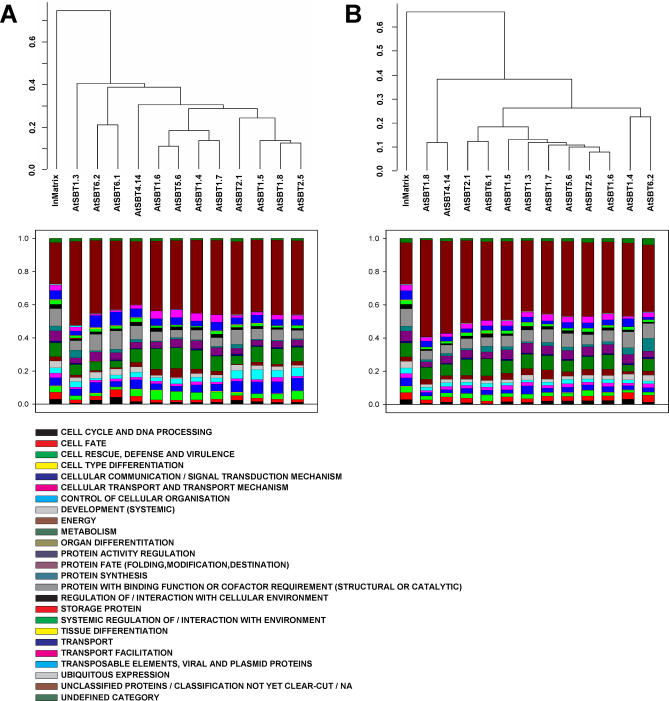
Result of the Co-Response-Based Transcriptional Neighbourhood Search for 12 Ubiquitously Expressed Subtilase GenesThe best 2% of positively correlated (A) and of negatively correlated (B) genes were selected and used to determine functional category representations. The upper chart represents the cluster tree resulting from our HCA analysis based on conversion of the enrichment of genes of particular functional categories into the Euclidean distances. In the lower chart, vertically stacked bar plots illustrate the distribution of functional categories of correlated gene for each of the 12 AtSBTs. For comparison, the functional category distribution of the genes represented in the underlying data matrices is shown to the left of each display.